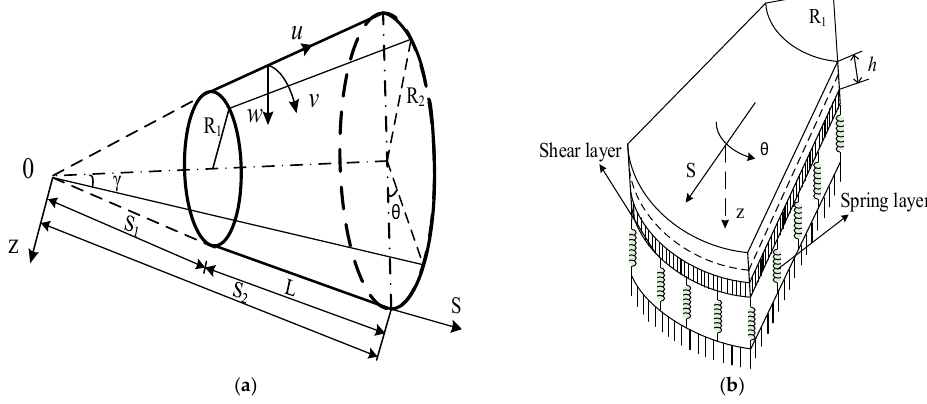
Figure 1. ( a ) The coordinate system and geometric characteristics of a FG-CNRTC truncated conical shell; ( b ) the geometric characteristics of the truncated conical shell surrounded by elastic foundations.